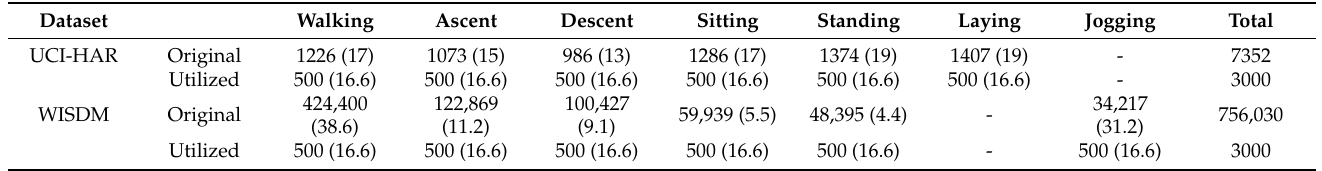
Table 4. Class distributions in benchmarking datasets (initial